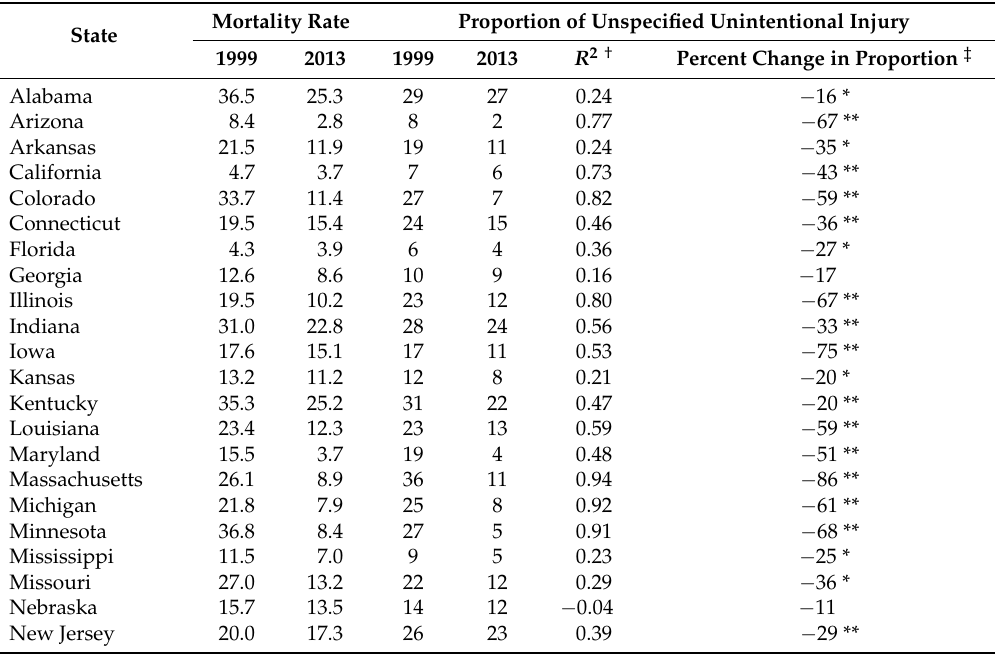
Table 1. Mortality rates and proportions of unintentional injury among Americans aged 65+ with unspecified cause by U.S. state,